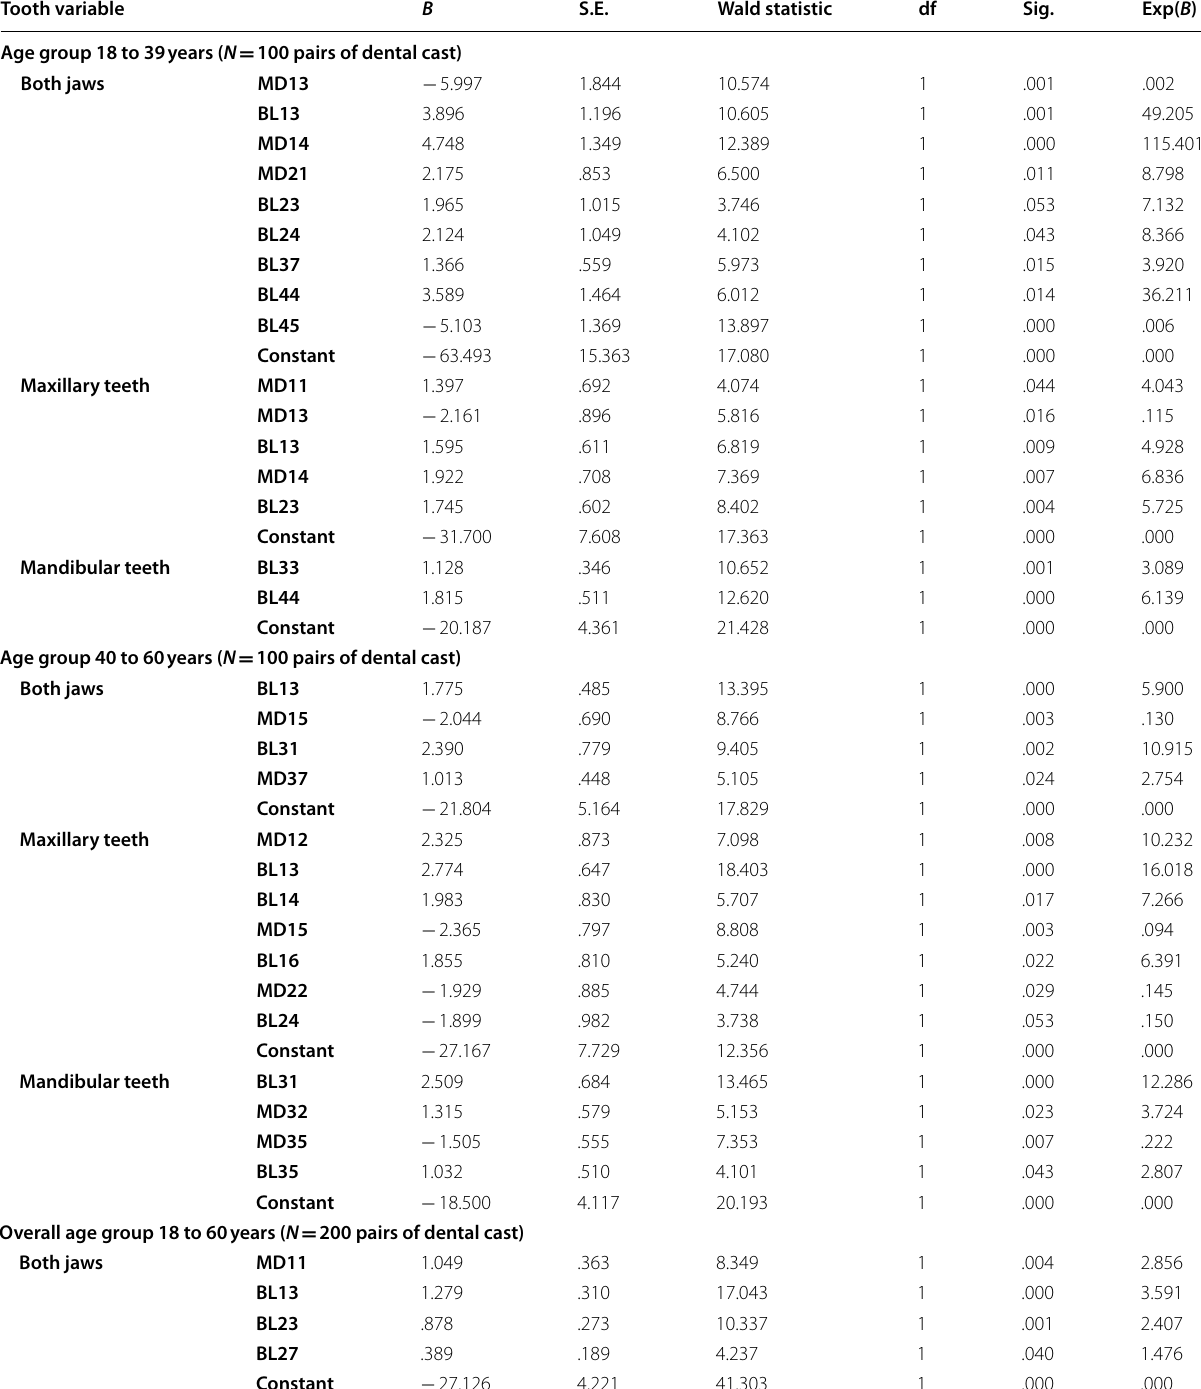
Table 4 Stepwise logistic regression analyses of teeth in both jaws and single jaw for age group 18 to 39 years, 40 to 60 years, and overall 18 to 60